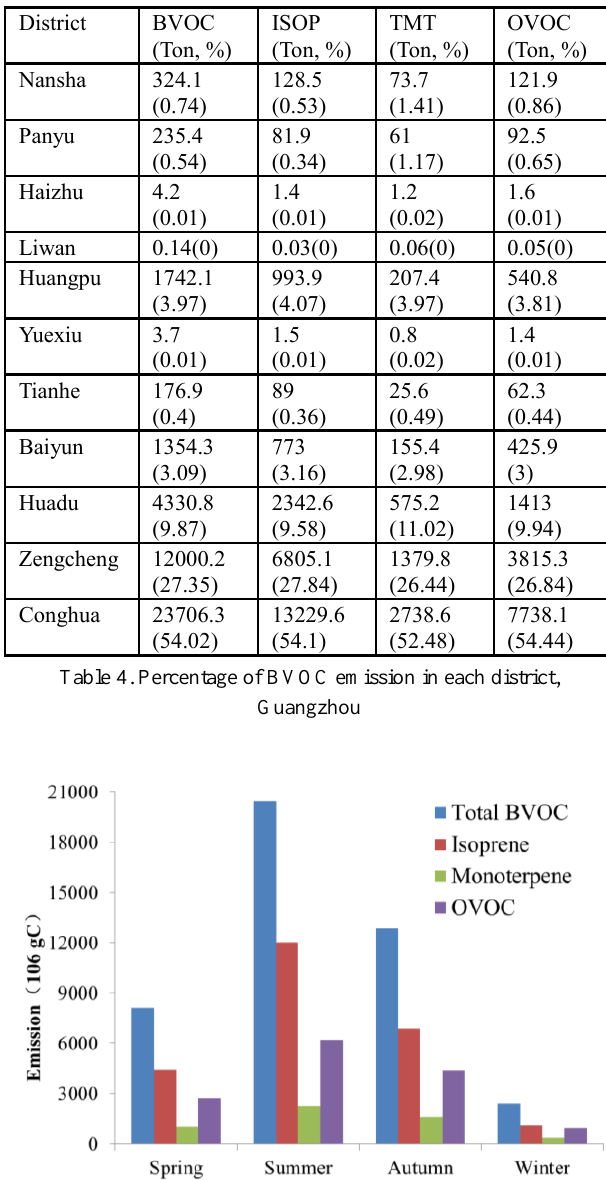
Figure 5. Seasonal variations of BVOC emissions in